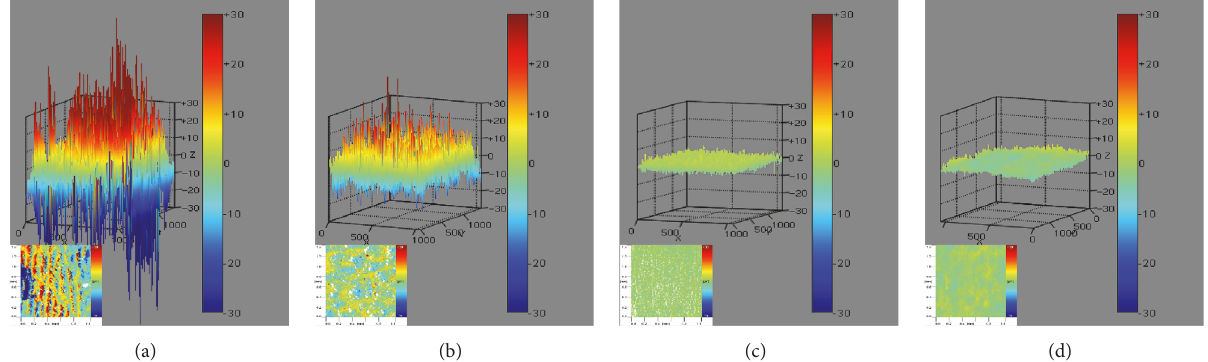
Figure 3: 3D surface roughness of the prepared PVB films under spin-coating 250 r/s (a), bar-coating 6 𝜇 m (b), positive electrospinning 15 cm (c), and negative electrospinning 15 cm (d). The inset images showed the 2D surface roughness of these